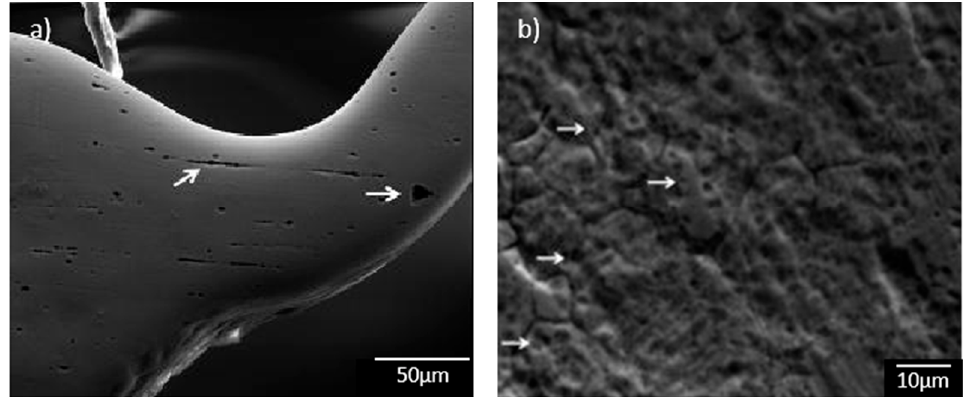
Figure 8. SEM images for ( a ) P11 sample at 400× magnification; ( b ) P1 sample at 4000× magnification.